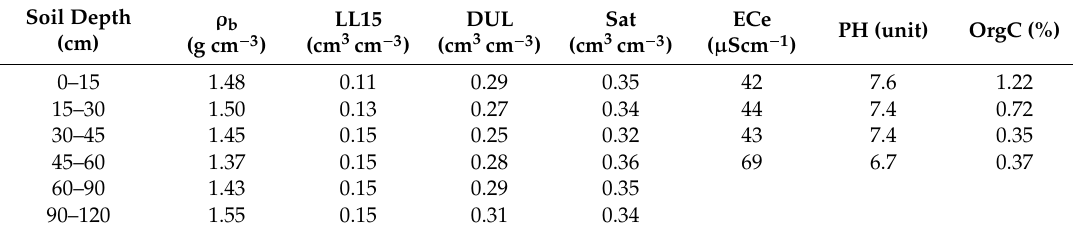
Table 1. Characteristics of the Red Kandosol soil at Wagga Wagga, Australia [25]. The soil chemical characteristics were measured during this